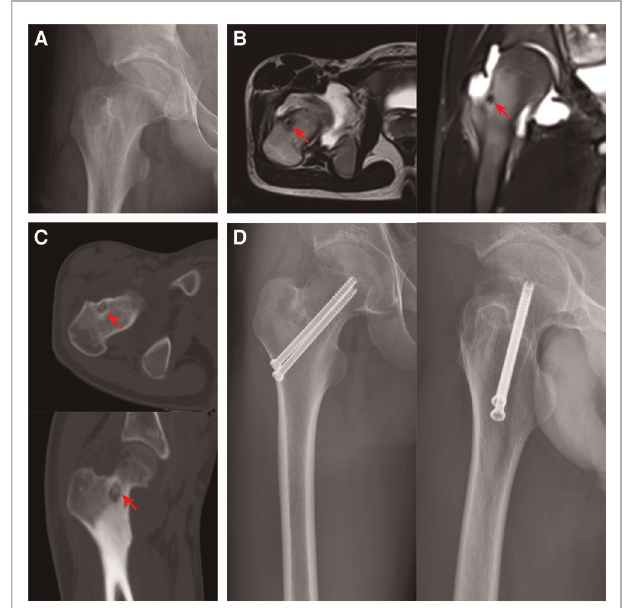
FIGURE 5 | Preoperative and postoperative imaging features of femoral neck OO. ( A ) The radiography showed a light transmission low-density lesion in the center of the base of the femoral neck. ( B ) The T2WI image of MRI showed low signal intensity, and the edema signal around the lesion was not obvious. ( C ) Thin-slice CT showed an osteolytic lesion in the anterolateral medulla at the base of the femoral neck with scattered calci fi cation. ( D ) The radiography fi ndings after curettage and bone grafting combined with cannulated screw prophylactic internal fi xation (The Red arrows indicate